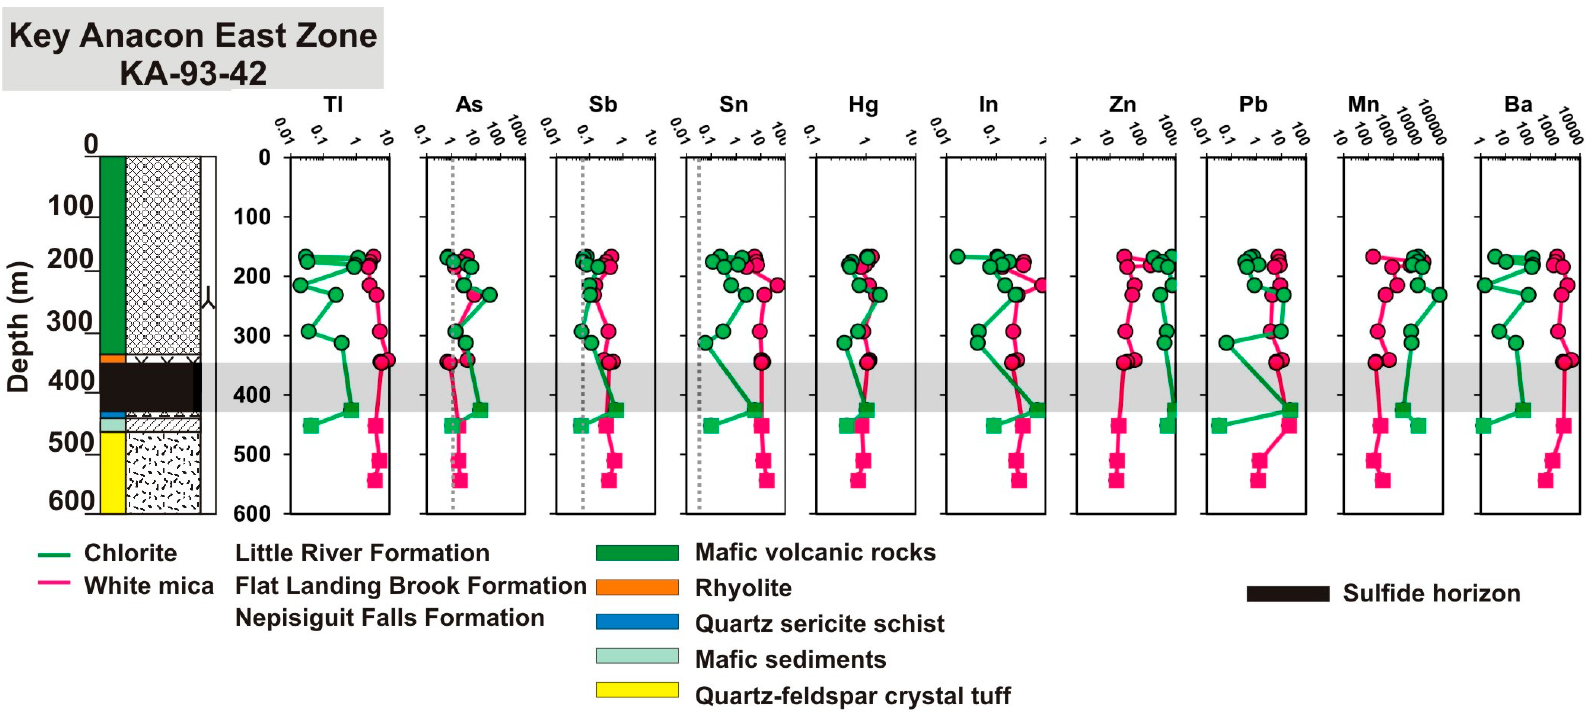
Figure 12. LA-ICP-MS geochemical data profiles illustrating fluid-mobile trace elements, as well as Zn, Pb, Mn, and Ba content (in ppm) of chlorite and white mica plotted with respect to the stratigraphy of the Key Anacon East zone intersected by drill hole KA-93-42 (see Supplementary Tables S6 and S7). Black outlined symbols denote hanging wall samples.